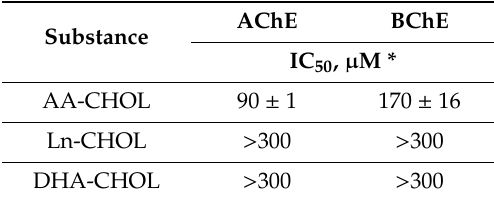
Table 3. Acylcholines inhibition of ATCh hydrolysis by acetylcholine degrading enzymes AChE and BChE.